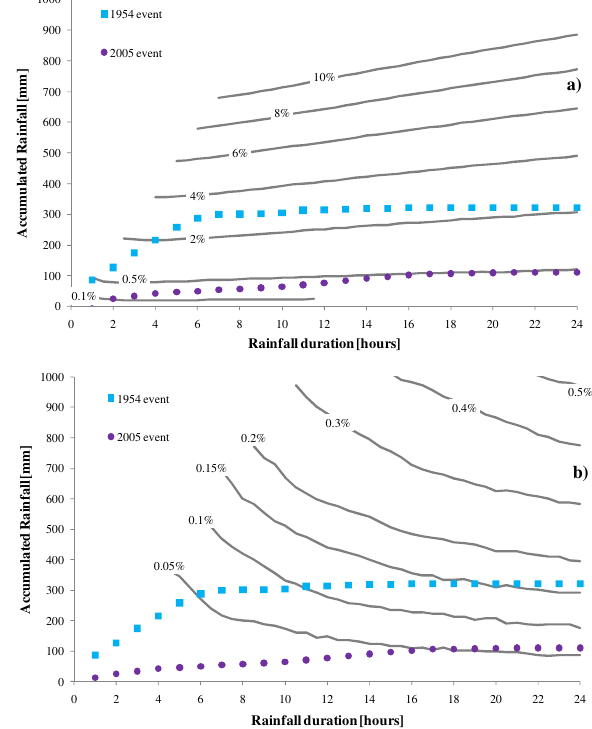
1 Fig. 11. Accumulated rainfall versus rainfall duration at fixed values Figure 11. Accumulated rainfall versus rainfall duration at fixed values of the failure 2 of the failure percentage: (a) sim01 with D 0 = 2 K z ; (b) sim04 with percentage: a) sim01 with D 0 =2K z ; b) sim04 with D 0 =0.1K z . 3 D 0 = 0 . 1 K z 4